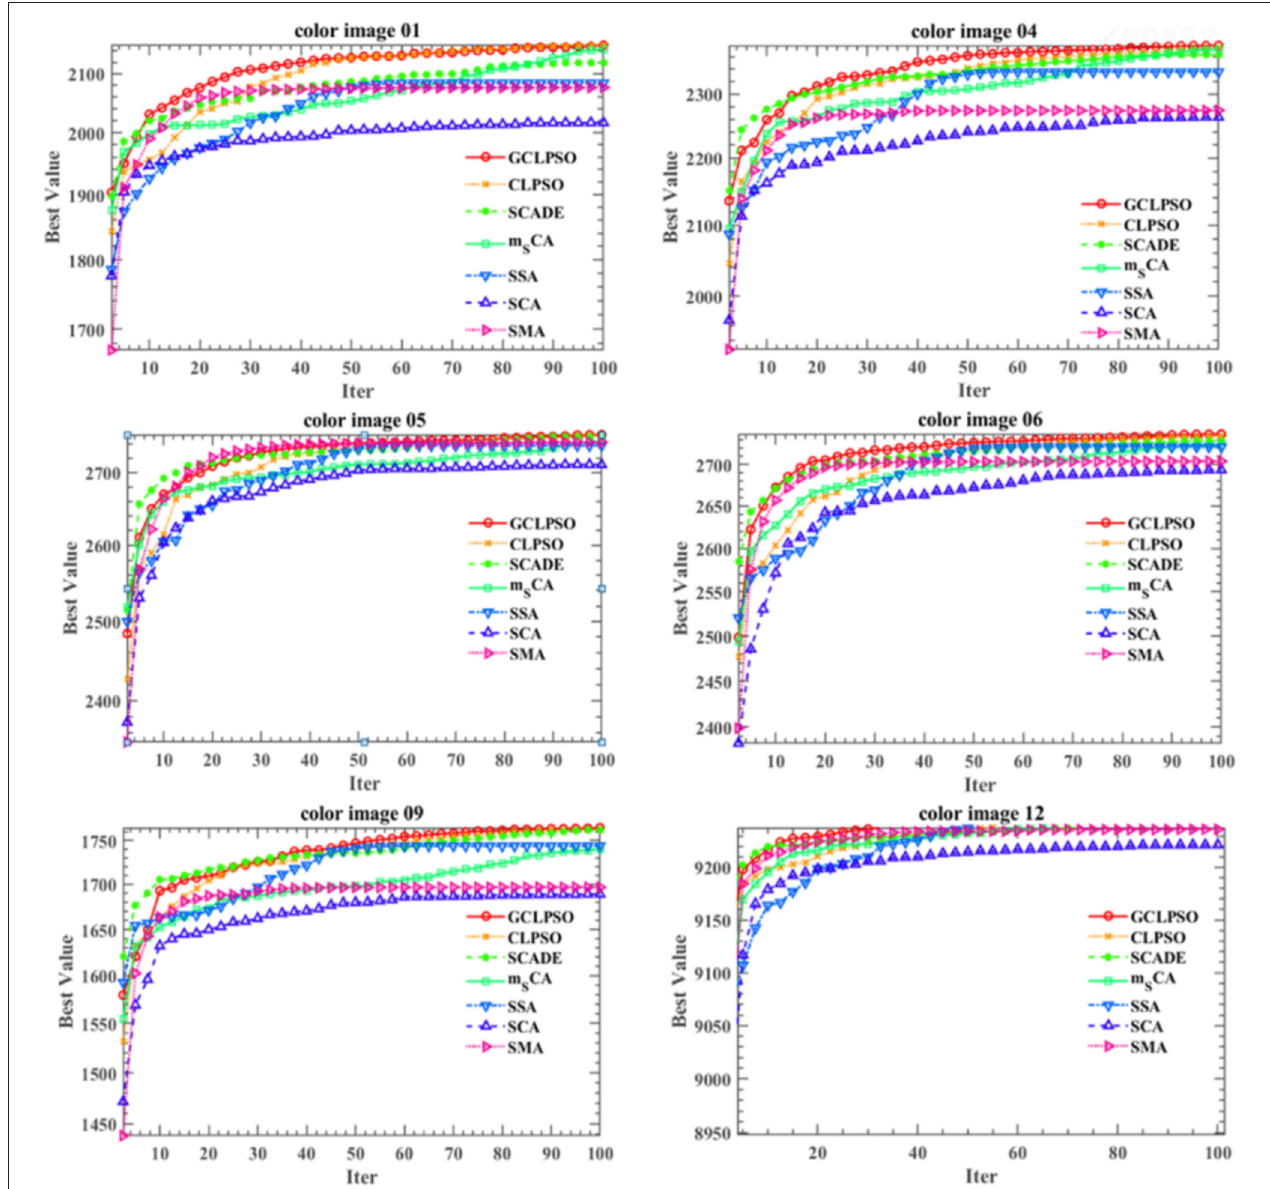
FIGURE 8 | Convergence curves of 2D-Otsu at threshold